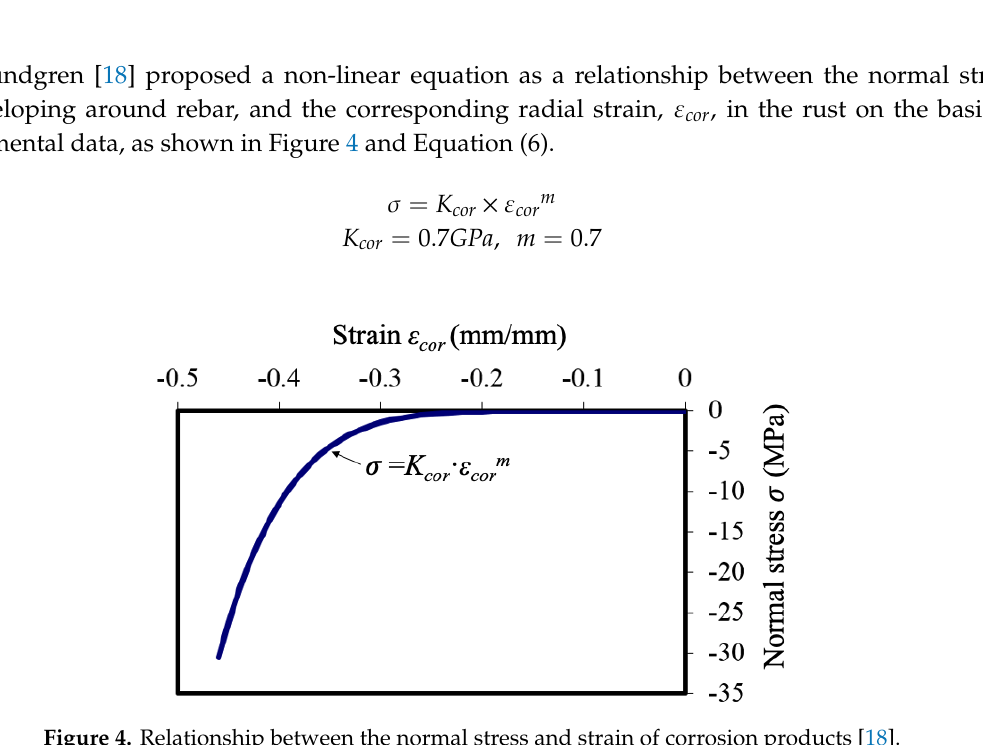
Figure 4. Relationship between the normal stress and strain of corrosion products [18].